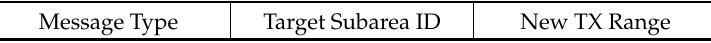
Table 1. The format of the power control message.